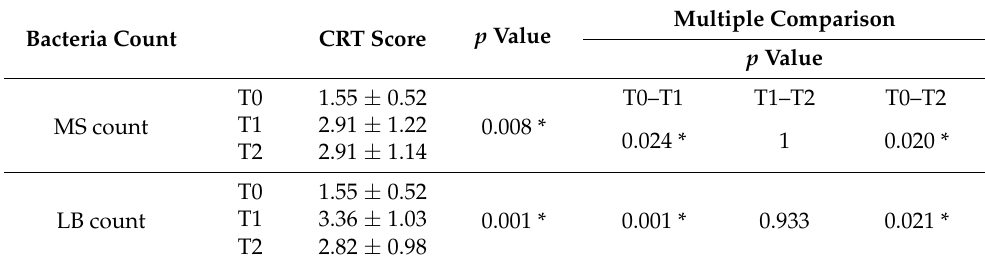
Table 3. CRT score of the low caries risk group among three time points. CRT Score p Value